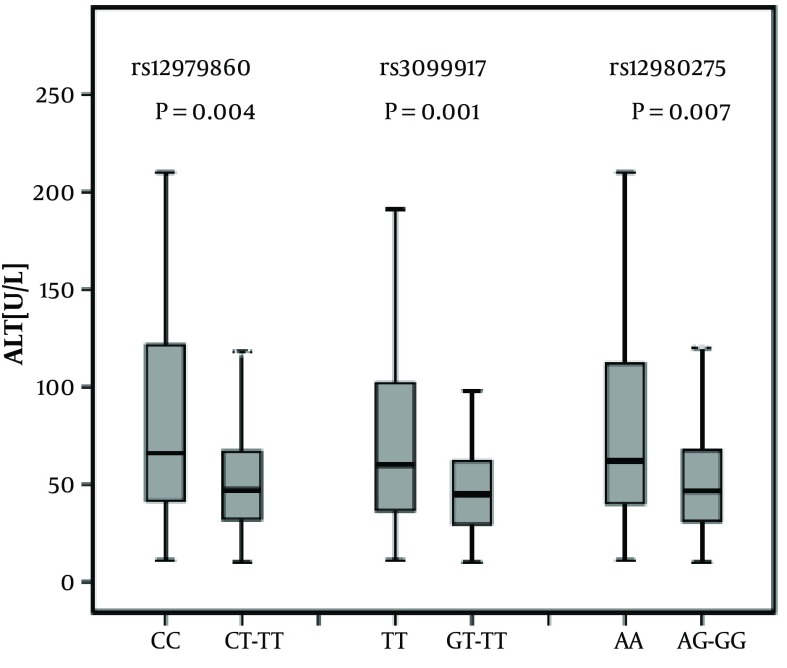
The Association of IL-28B SNP With Baseline ALT Activity in Chronic HCV PatientsThe ALT levels were significantly lower in patients carrying the unfavorable alleles (T of rs12979860, G of rs8099917 and G of rs12980275). Data are median with 10th, 25th, 75th and 90th percentiles as vertical boxes with error bars.